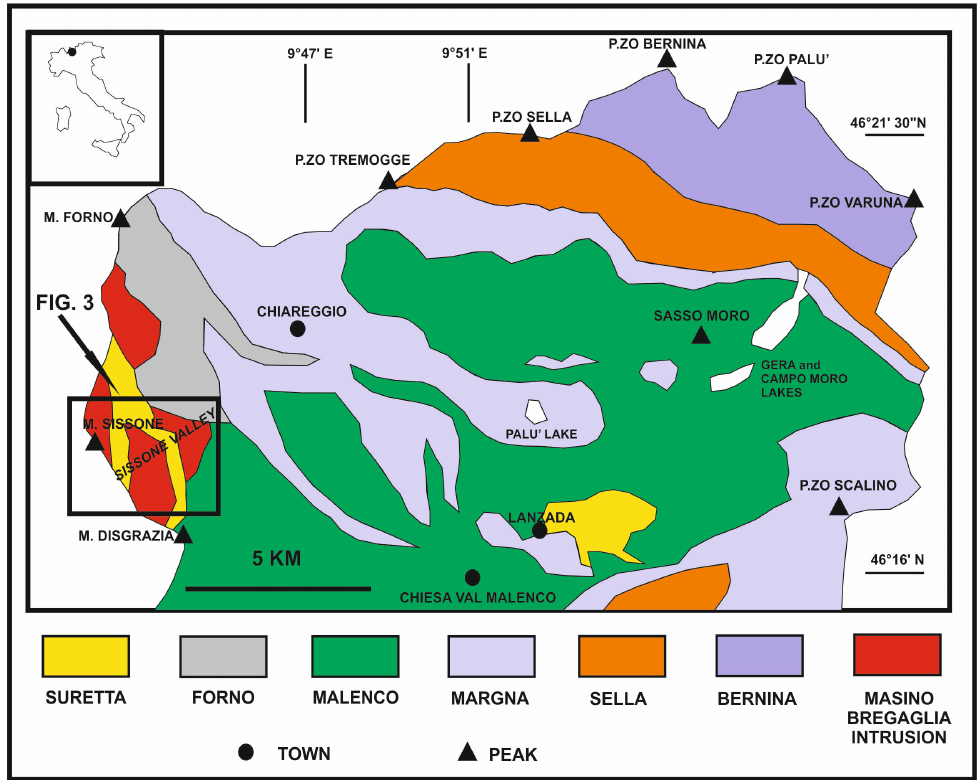
Figure 2. Tectonic map with the nappes of Malenco valley. Every nappe is composed by a Paleozoic crystalline basement and a Permo-Mesozoic sedimentary cover. The Masino-Bregaglia intrusion is dated to the Cenozoic Era. Map redrawn from [13].